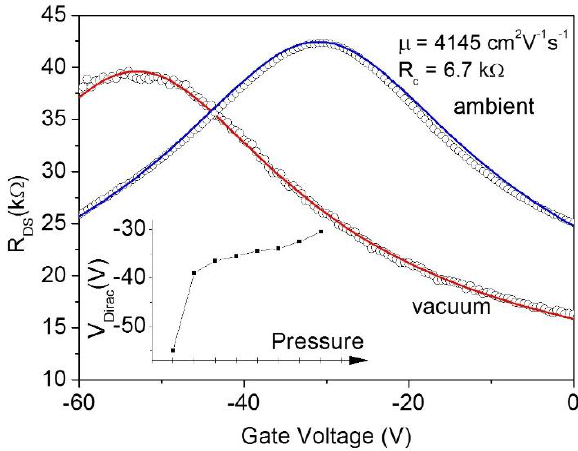
Figure 4. The effect of the pressure variation from high vacuum to ambient conditions on the R DS vs. V Gate curve reported in Figure 3a. Solid lines are the fitting curves. Inset: evolution of the Dirac point for increasing pressure.